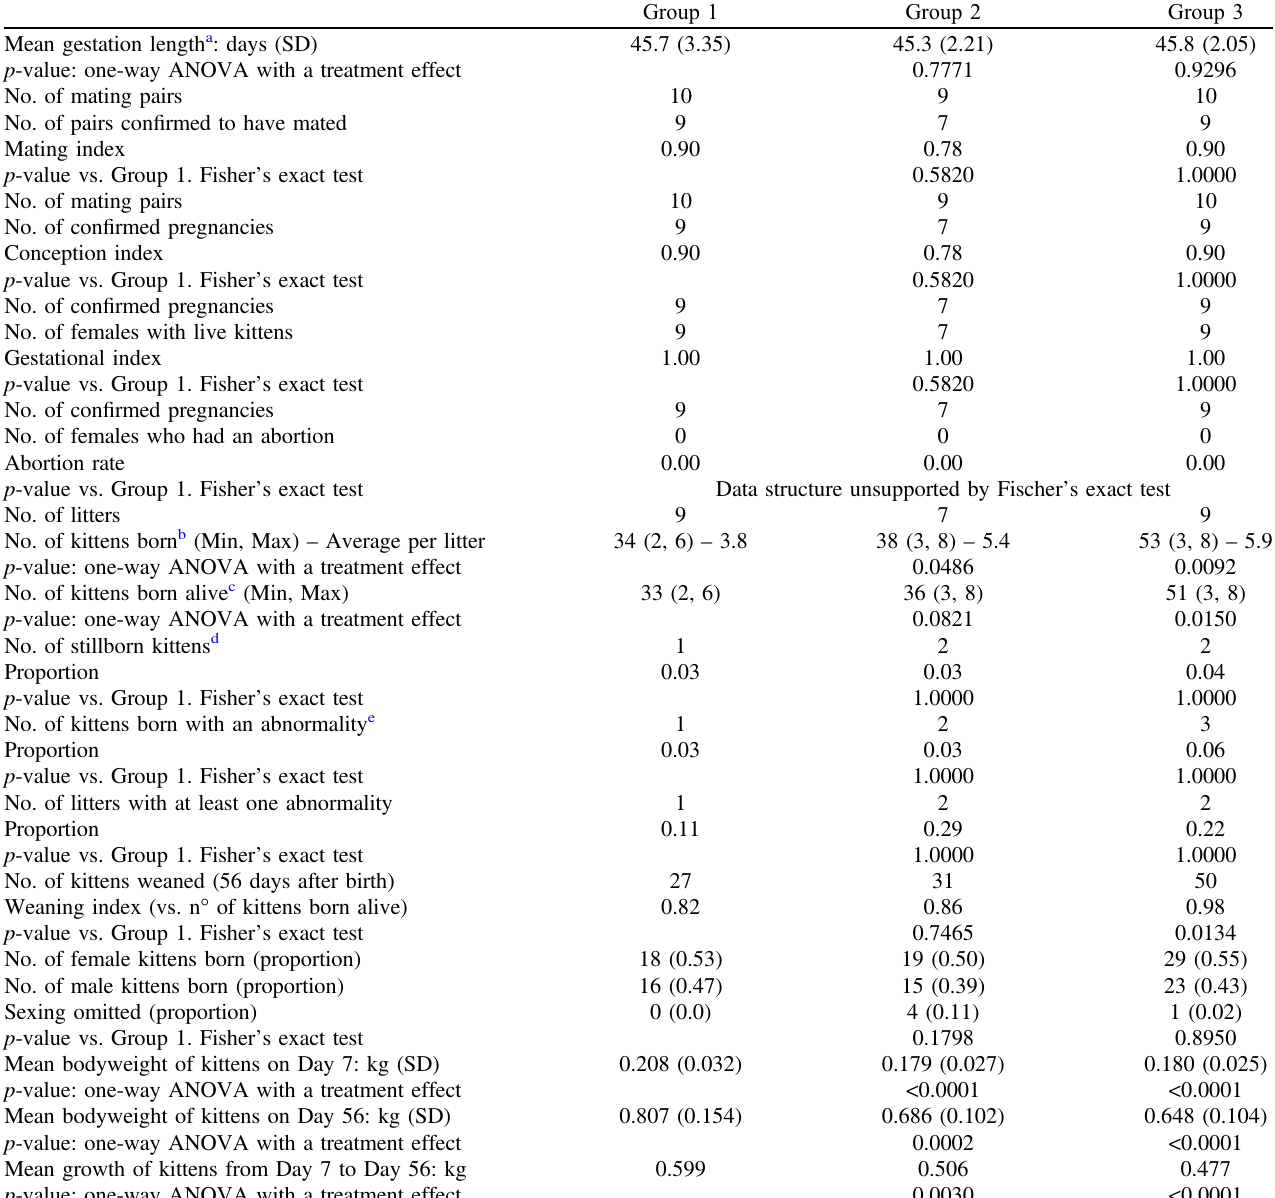
Table 1. Breeding parameters, statistical analyses, and